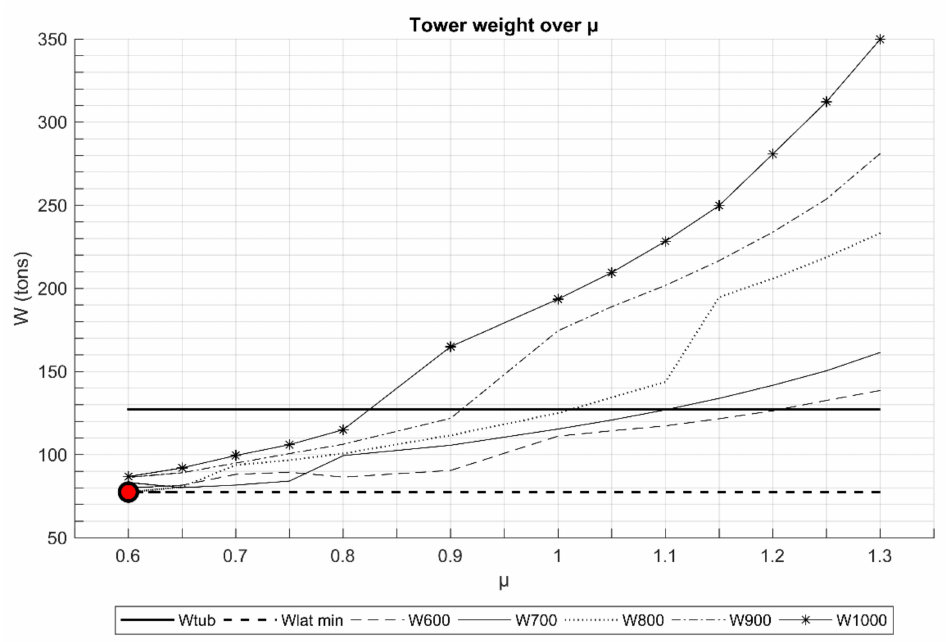
Figure 12. Total weight of tower cases in correlation with µ and B top for the 76 m towers.